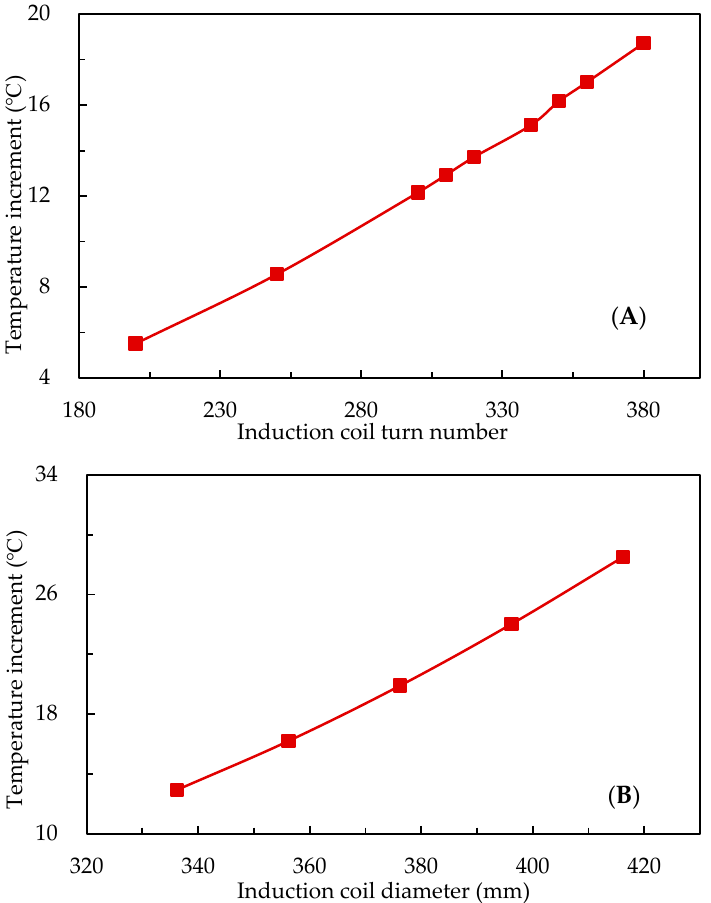
Figure 9. Effects of induction coil turn number and diameter on wax layer temperature increment. ( A ) Induction coil turn number (original wax layer temperature is 20 ◦ C, electrical current intensity is 20 A, magnetic field frequency is 500 kHz, SPM-NP diameter is 18 nm, pig velocity is 0.4 m/s, the flow rate is 0.4 m/s, and nanoparticle content is 10%) and ( B ) induction coil diameter (original wax layer temperature is 20 ◦ C, electrical current intensity is 20 A, magnetic field frequency is 500 kHz, SPM-NP diameter is 18 nm, pig velocity is 0.4 m/s, the flow rate is 0.4 m/s, induction coil turn number is 310 turns, and nanoparticle content is